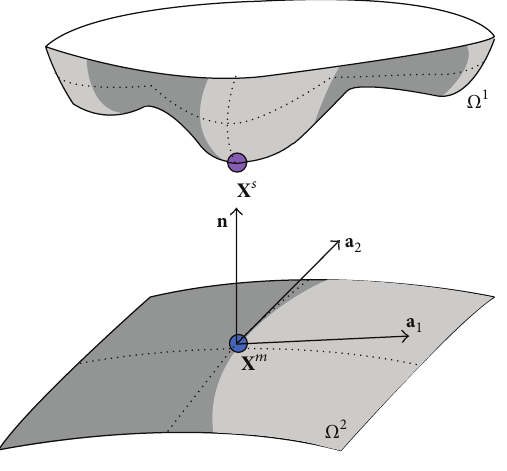
Figure 4: Contact scheme.